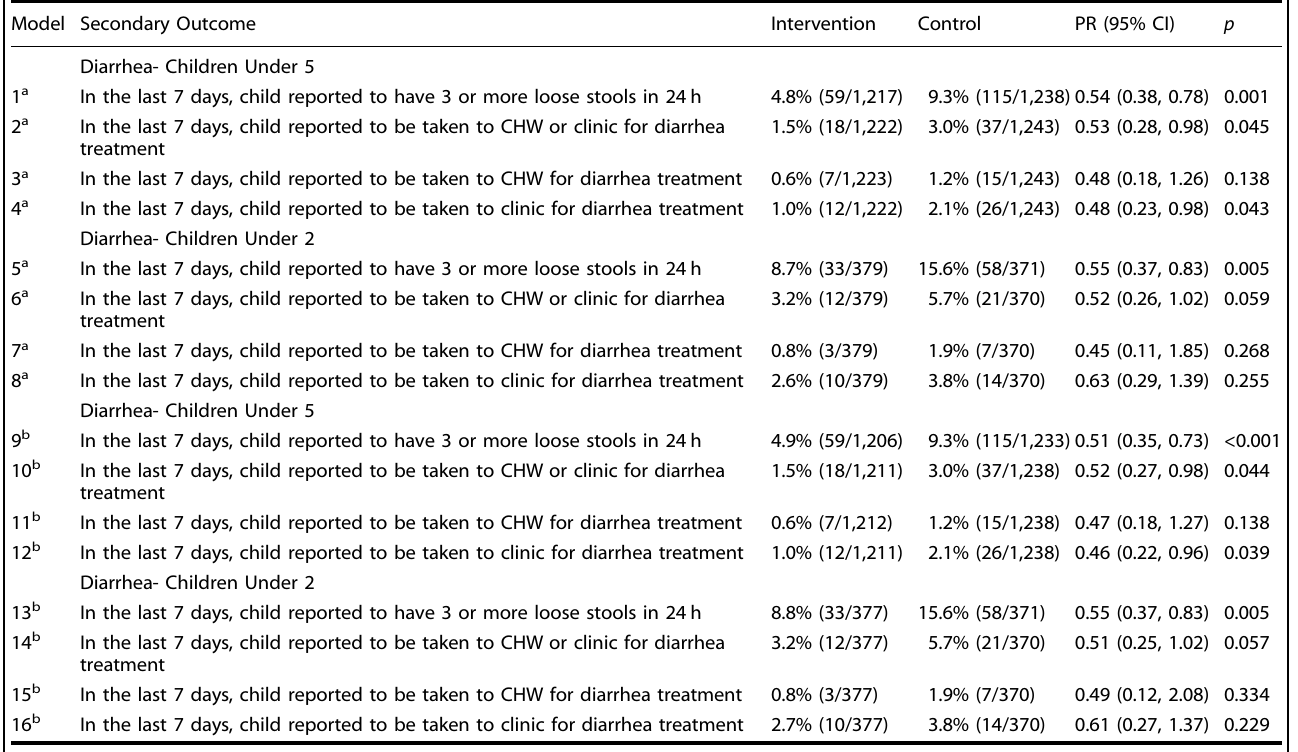
Table 4. Effects of intervention during follow-up on diarrhea outcomes for children under 5 and 2. Model Secondary